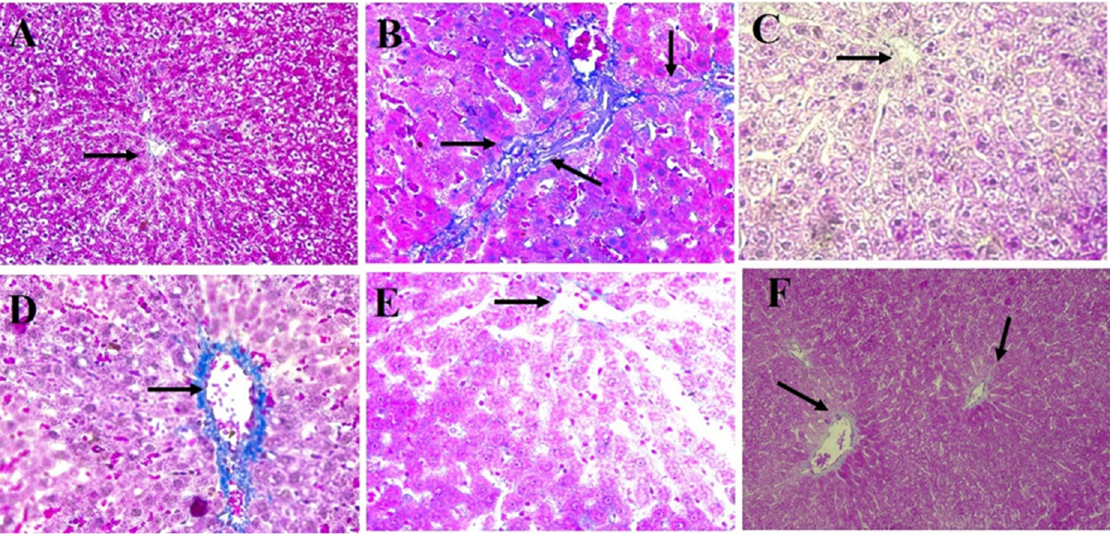
Figure 12. Masson Trichrome staining of liver sections (200X). ( A ) Control; ( B ) BPA; ( C ) MOLE; ( D ) MOLE ‐ BPA; ( E ) Encap. MOLE; ( F ) Encap. MOLE ‐ BPA.